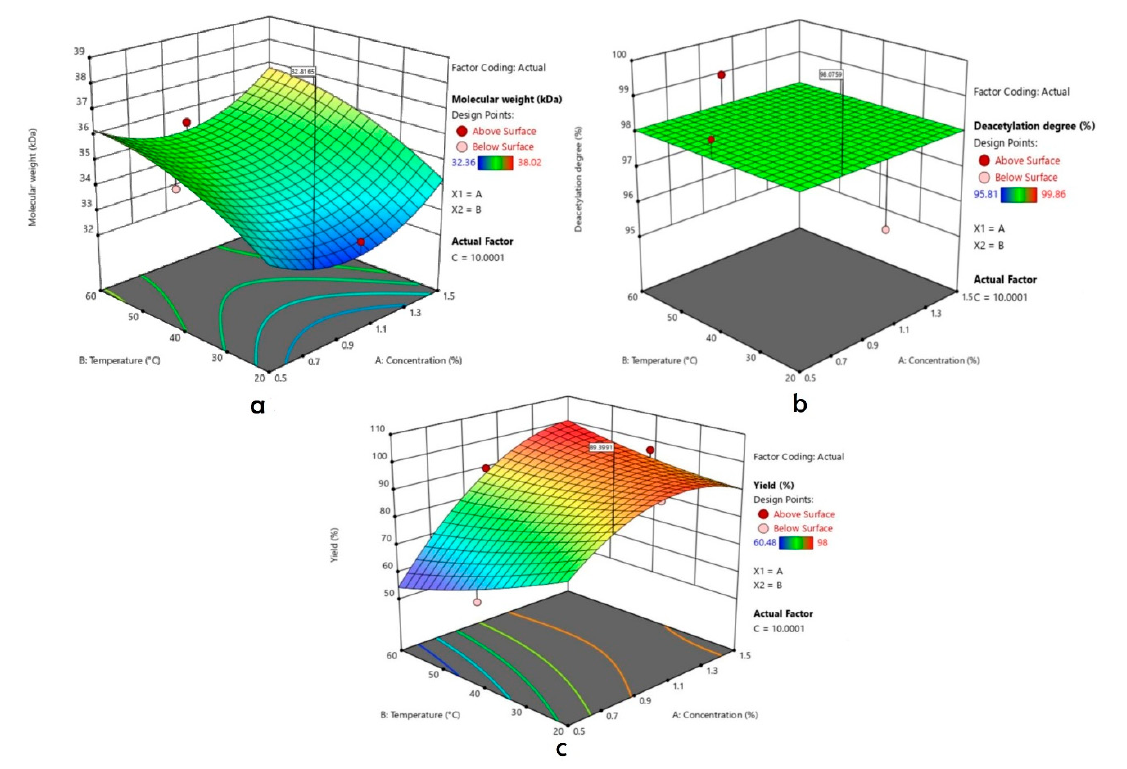
Figure 3. Three-dimensional diagram of ( a ) molecular weight, ( b ) deacetylation degree, and ( c ) yield prediction of the developed model.